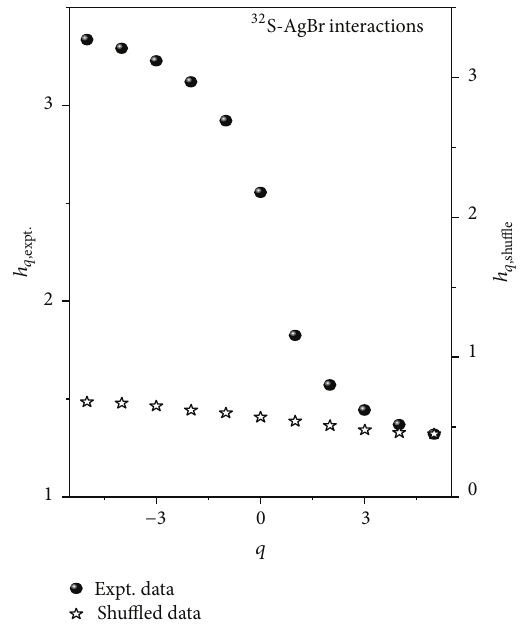
Figure 2: Plot of variation of generalized Hurst exponent ( ℎ 𝑞 ) with order ( 𝑞 ) for all the interactions.